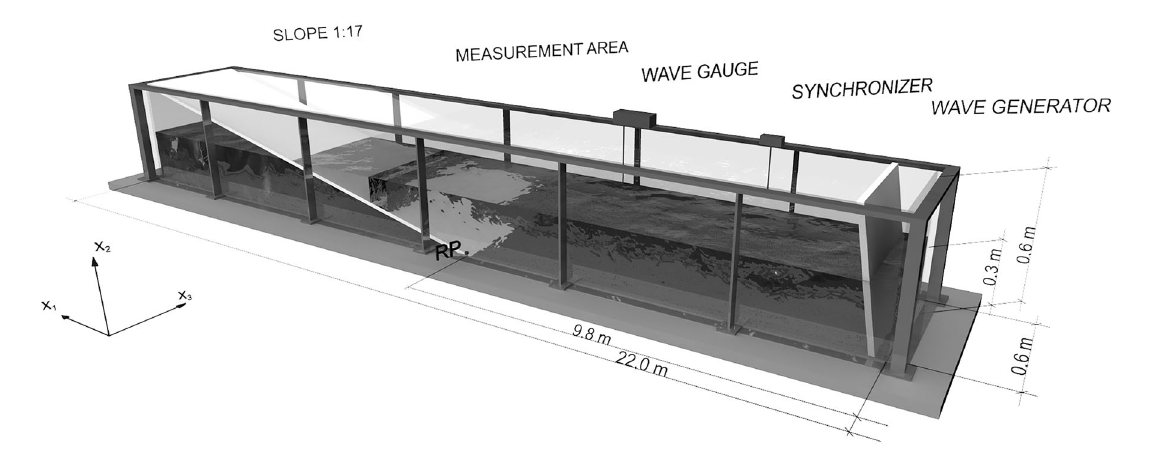
Fig. 1. Bird view of the wave flume: dimensions and